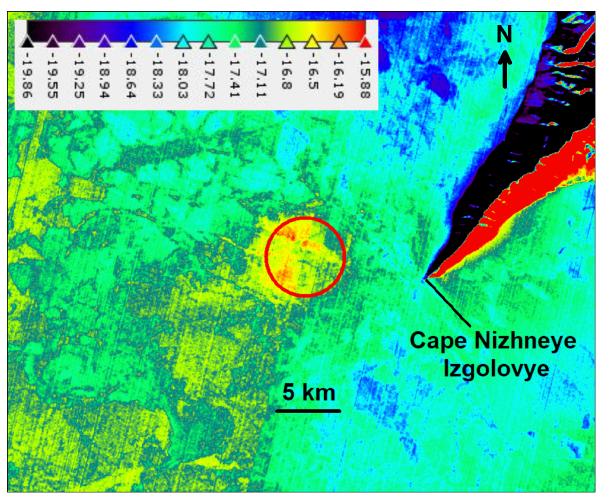
Figure 12. Ice and land surface temperature ( ◦ C) from Landsat 8 image on 6 March 2018. Red circle – position of outer eddy limit as defined from in situ data in February 2018. Projection UTM